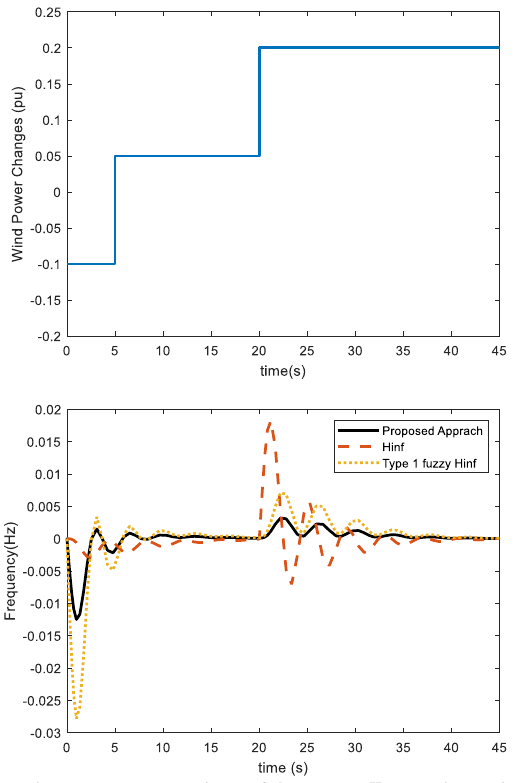
Figure 16. Comparison of the controller against wind power